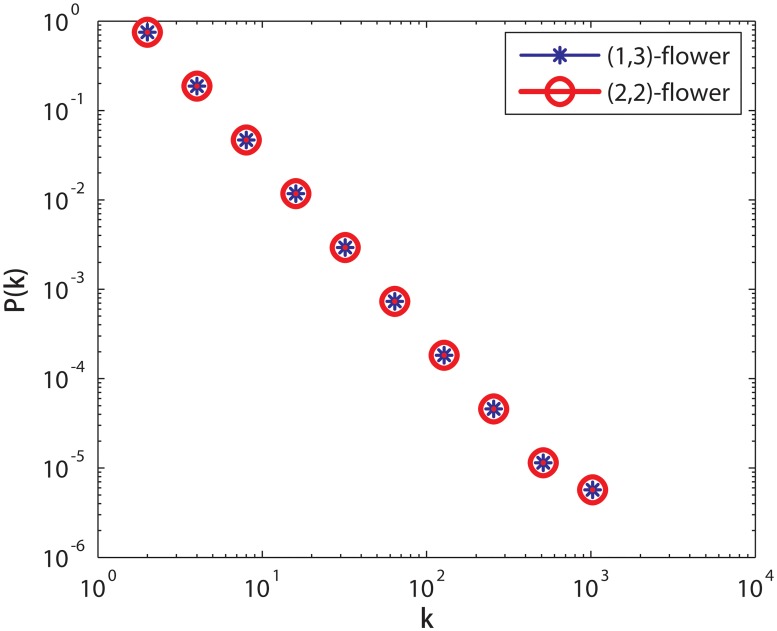
The degree distribution of F
t(1, 3) and F
t(2, 2).Two networks have identical degree distribution and their degree distribution obey a power-law degree distribution P(k) ∼ k
−3.